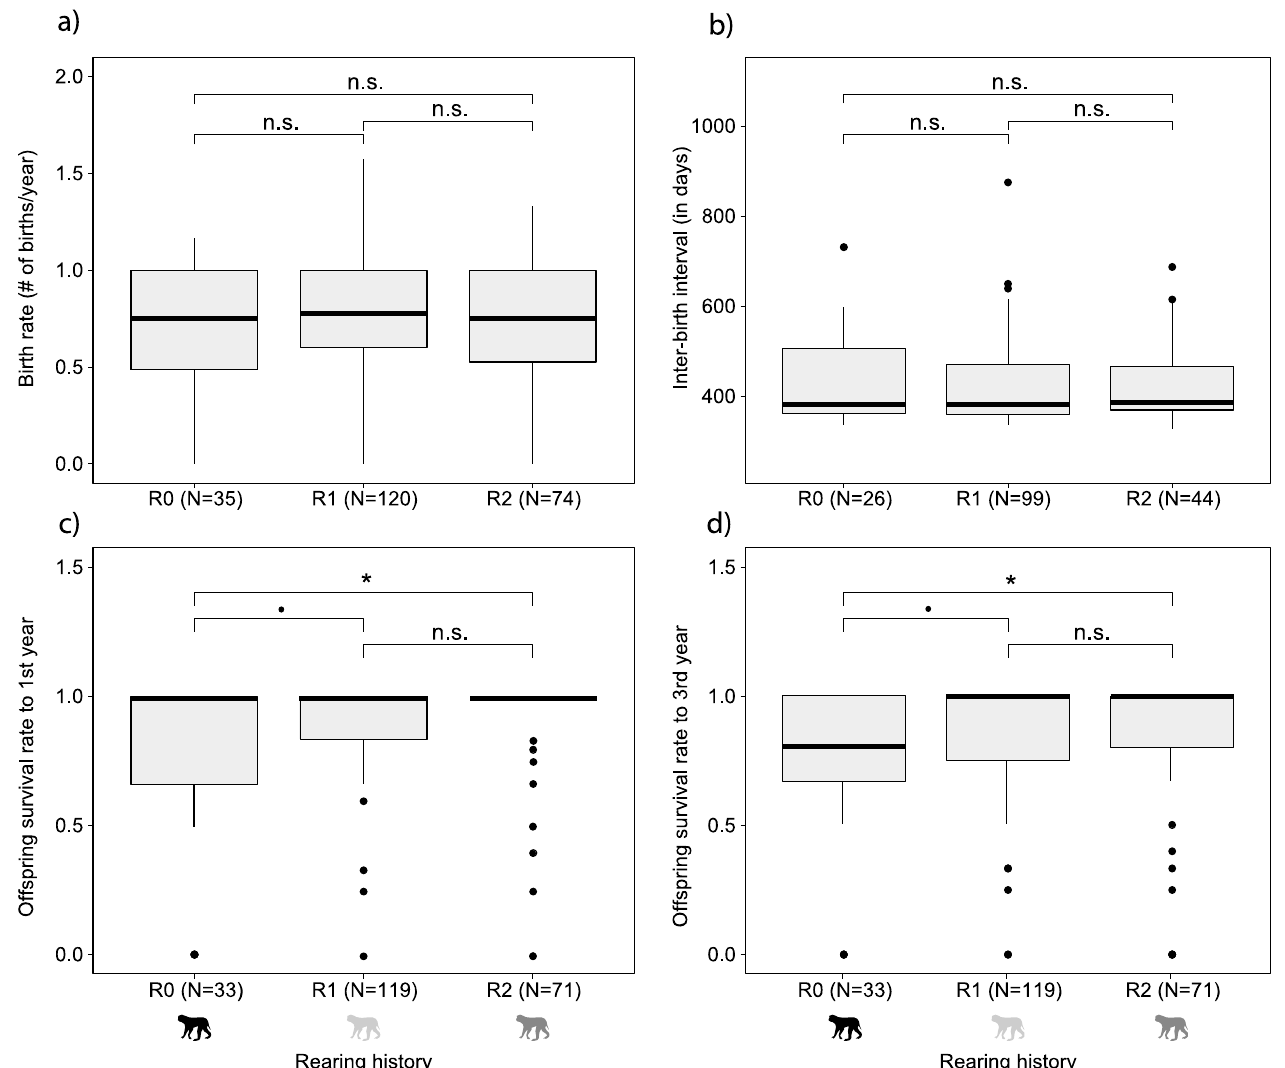
Figure 3. Birth rates, IBIs and offspring survival per rearing history, within multigenerational breeding groups: ( a ) birth rates were not affected by female rearing history in captive rhesus macaques (R0 = peer- or hand-reared; R1 = group-reared with peer- or hand-reared mother; R2 = group-reared); ( b ) IBIs were also not affected by female rearing history; ( c ) offspring survival to first year and ( d ) three years of age was significantly lower in R0 compared with R2. * indicates p ≤ 0.05; • indicates 0.05 < p < 0.10.